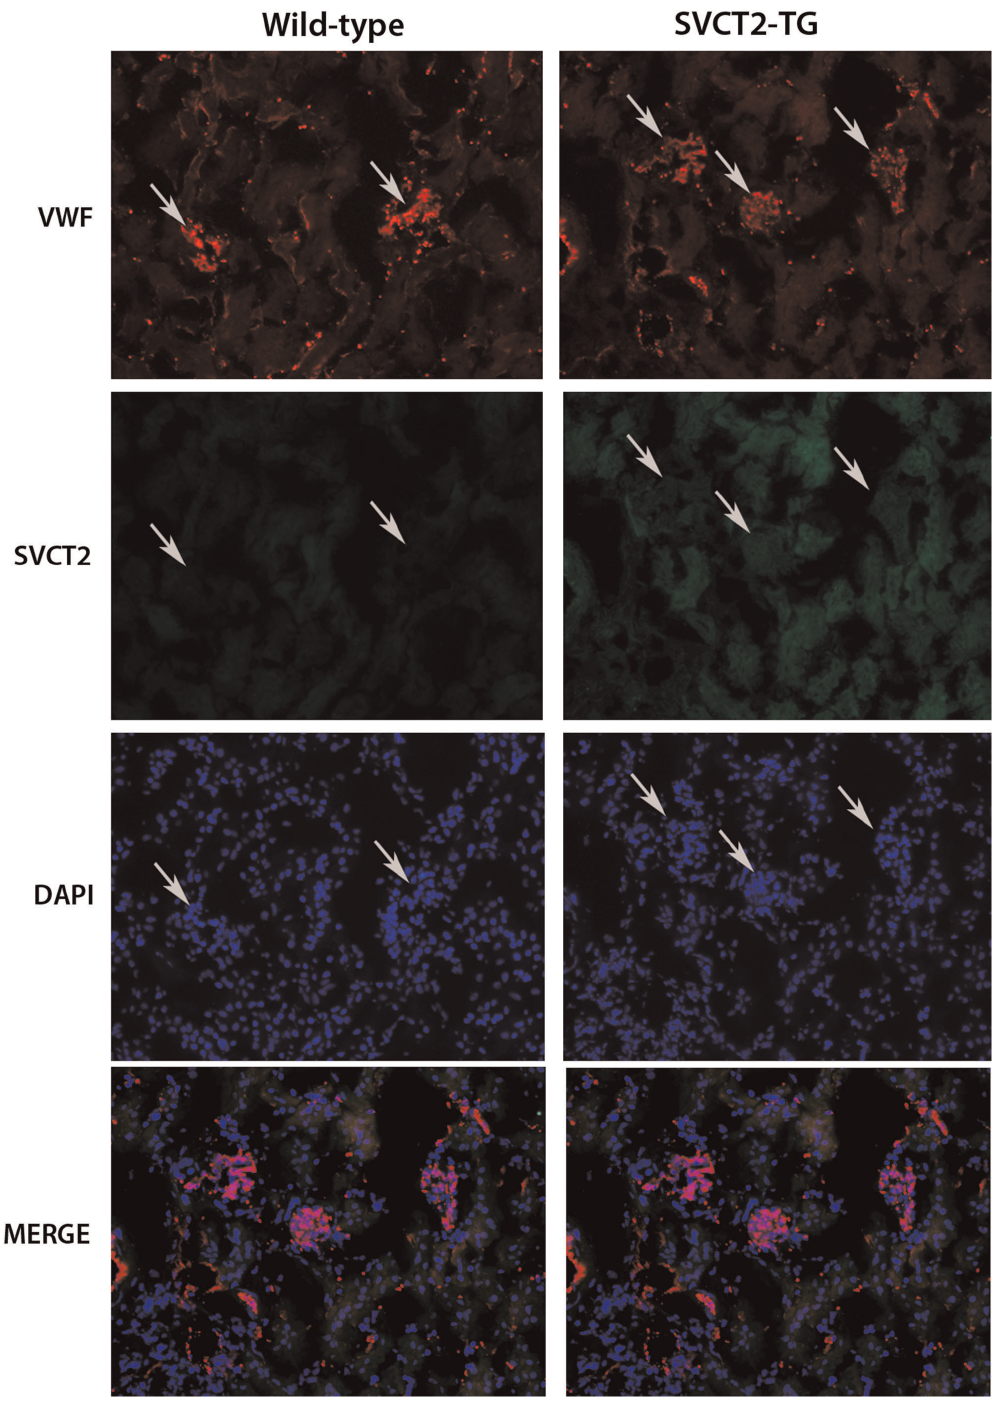
Figure 5. SVCT2 location in kidney. 5 m m frozen kidney sections were stained for von Willebrand factor (VWF, red) and for SVCT2 (green) with non-specific stain for nuclei (blue) in wild-type (left panels) and SVCT2-Tg (right panels) kidneys. Heavier staining for VWF is observed in glomeruli (arrows) with corresponding areas of low staining for SVCT2 and high density of nuclei. A merged image (bottom panels) confirms lack of overlap of SVCT2 and VWF in glomeruli. Images taken at 20X magnification. doi:10.1371/journal.pone.0035623.g005 and genotype (p = 0.591). Despite varying amounts of exploration in and learned to perform well on the rotorod, as shown by increasing themaze,alternationbehaviordidnotvaryaccordingtogenotypeor trial times across the three test sessions (ps , 0.001; Fig. 6D). There were no effects of gender or genotype on performance in time to first gender(ps . 0.36;Fig.6Cii)indicatingintactspatialworkingmemory in the SVCT2-Tg mice. All mice had normal sensorimotor abilities rotation or to fall (ps . 0.233).